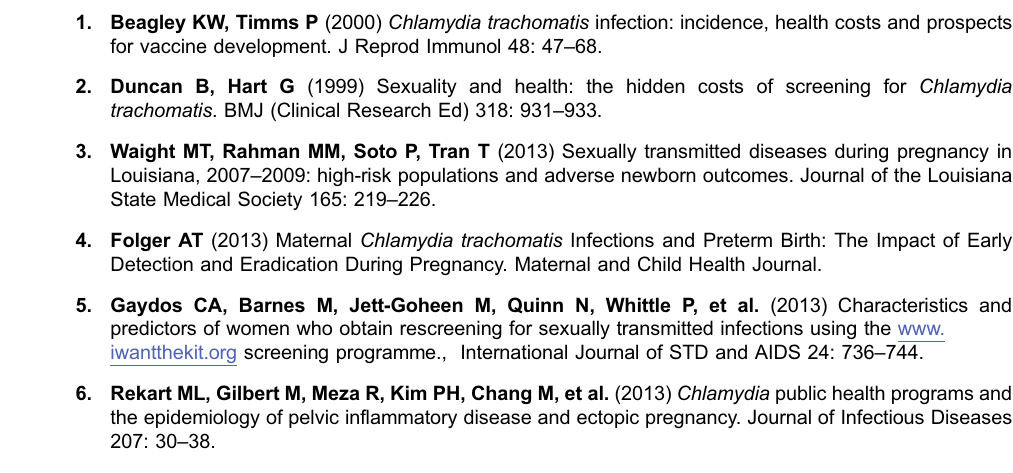
S1 Figure. Effect of C. caviae EB Vaccination on Histopathology in the Oviduct and Cervix from Guinea Pigs following Chlamydial Challenge. The genital tracts of each guinea pig were removed at day 80 post-challenge with Chlamydia , sectioned and analyzed using microscopy following H&E staining. Injury scores were calculated using the criteria as described in the Methods. Graphs are expressed as mean ¡ SD and compared using paired t-test. The asterisk indicates statistically significant differences (* p , 0.05) between C. caviae vaccination and mock vaccination group for the edema score. S2 Figure. Illustration of the Guinea Pig Immune Gene Array.